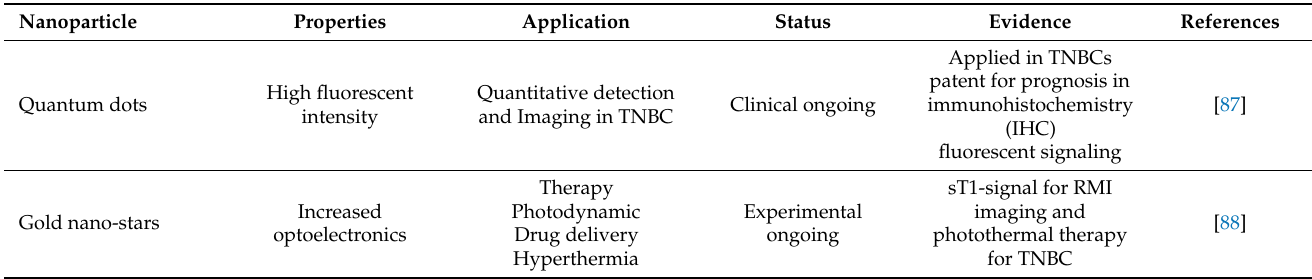
Table 2. Nanomedicine for triple-negative breast cancer